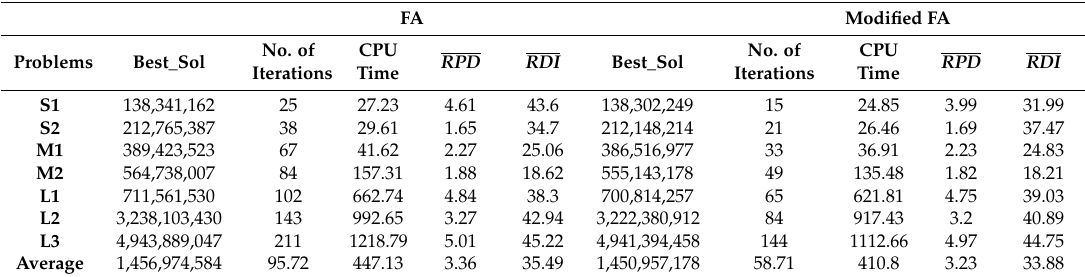
Table 3. Performances comparison of FA and modified